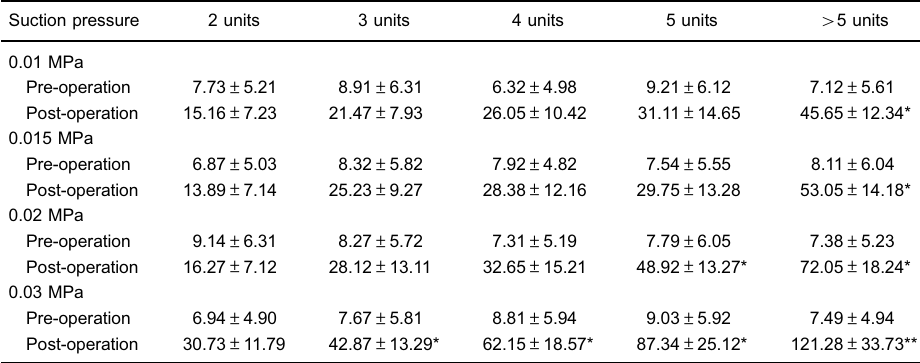
during the intraoperative salvage autotransfusion (paired t